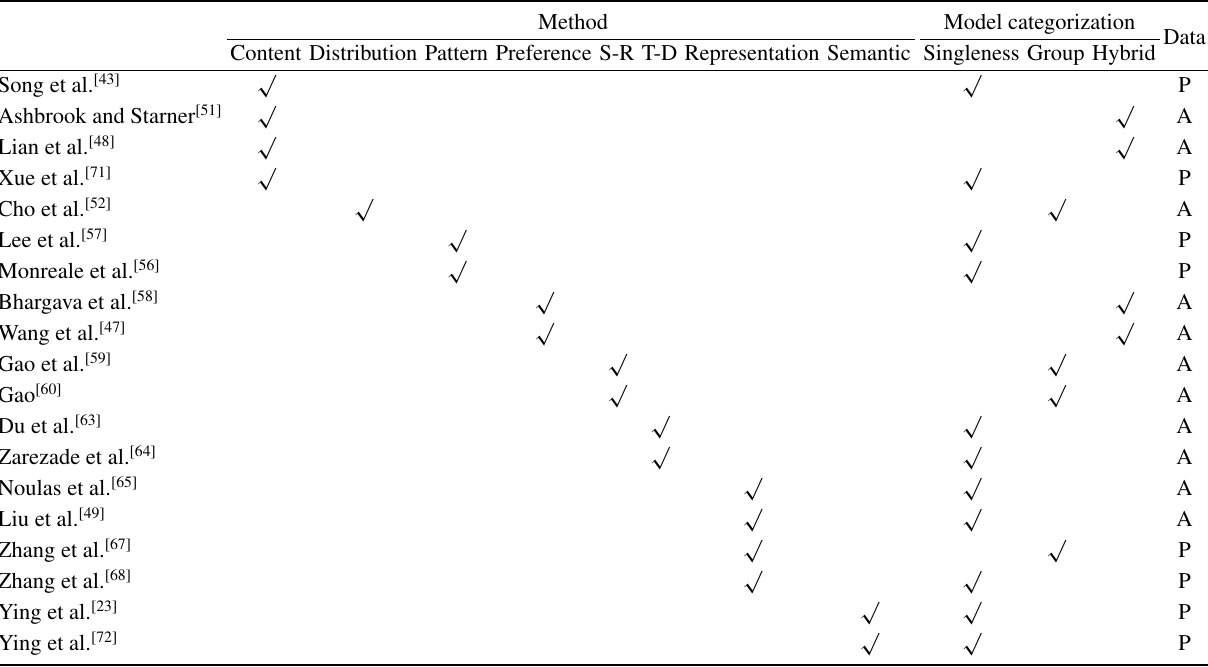
Table 4 Summary of existing location prediction algorithms. (Social relation based prediction algorithm: S-R; time